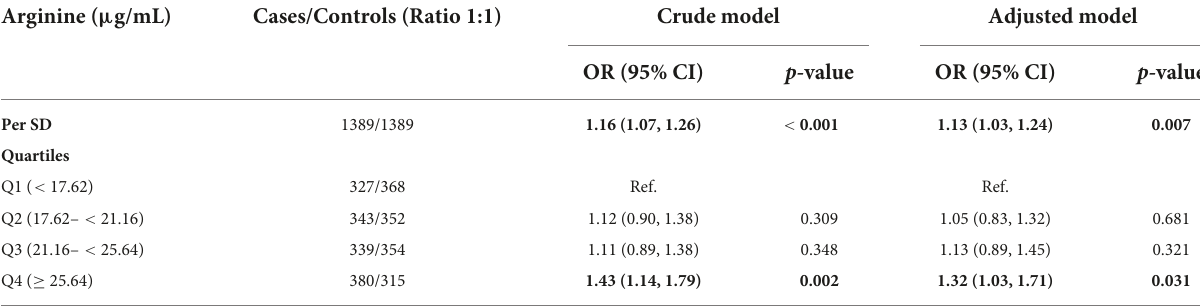
TABLE 2 The association of serum arginine with overall cancer risk.